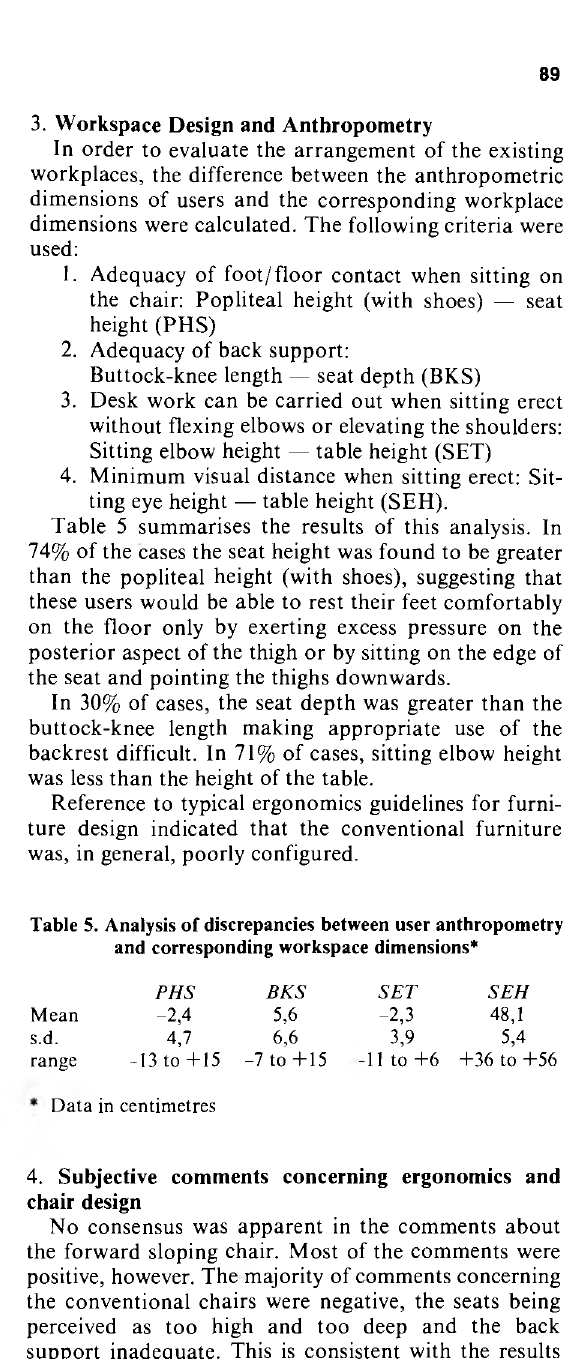
Table 4. Pain/discomfort by anatomical region*